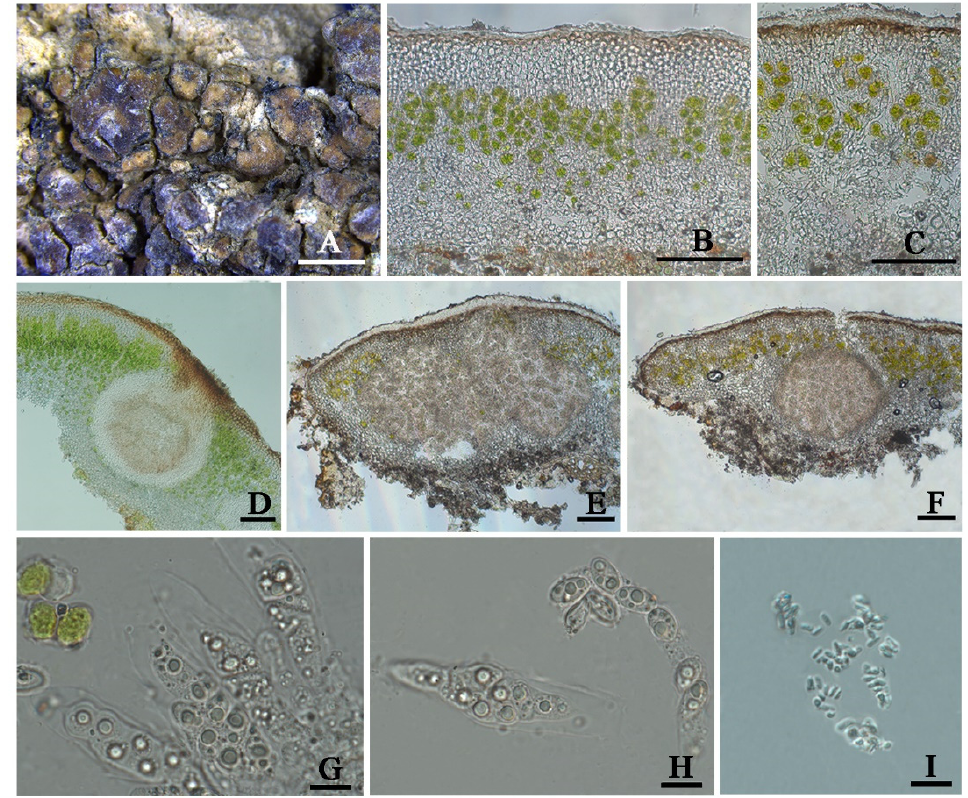
Figure 6. The thallus habit and the anatomic structure of Placidium nigrum sp. nov (HMAS-L 153950). ( A ). Squamulose thallus. ( B , C ). Thallus section. ( D ). Immersed perithecium. ( E , F ). Dermatocarpon -type pycnidia. ( G , H ). Asci with ascospores. ( I ). Conidia. Bars: ( A ) =2 mm, ( B , C ) =100 µm, ( D ) =200 µm, ( E , F ) =100 µm, and ( G – I ) =10 µm. Placidium varium T.T. Zhang & X.L. Wei, sp. nov. (Figure 7)